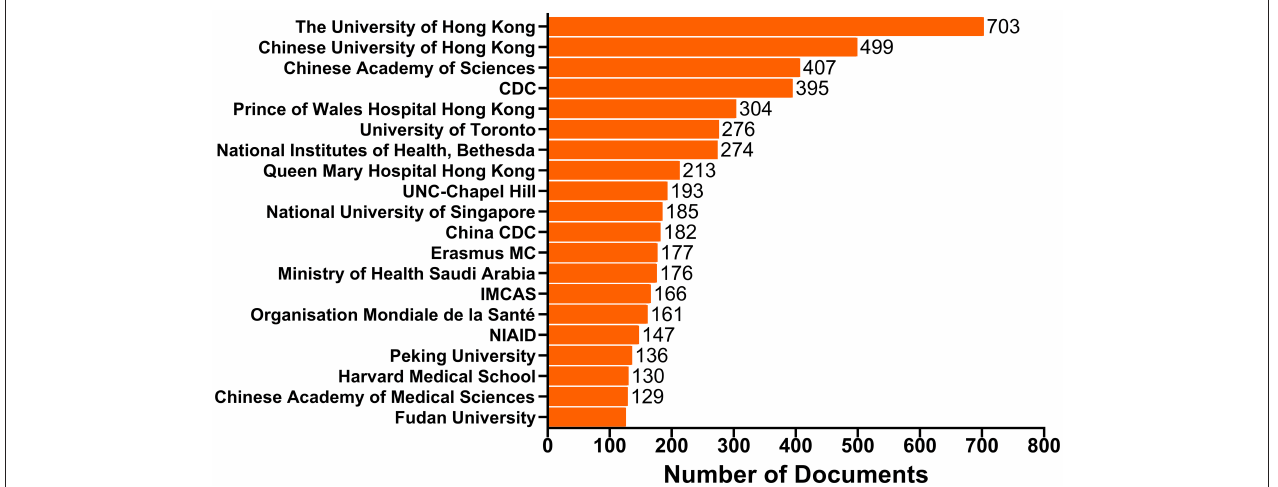
FIGURE 3 | Top 20 affiliations with the most publications. The bars show the number of documents produced by the affiliation. CDC, Centers for Disease Control and Prevention; UNC-Chapel Hill, The University of North Carolina at Chapel Hill; China CDC, Chinese Center for Disease Control and Prevention; IMCAS, Institute of Microbiology Chinese Academy of Sciences; NIAID, National Institute of Allergy and Infectious